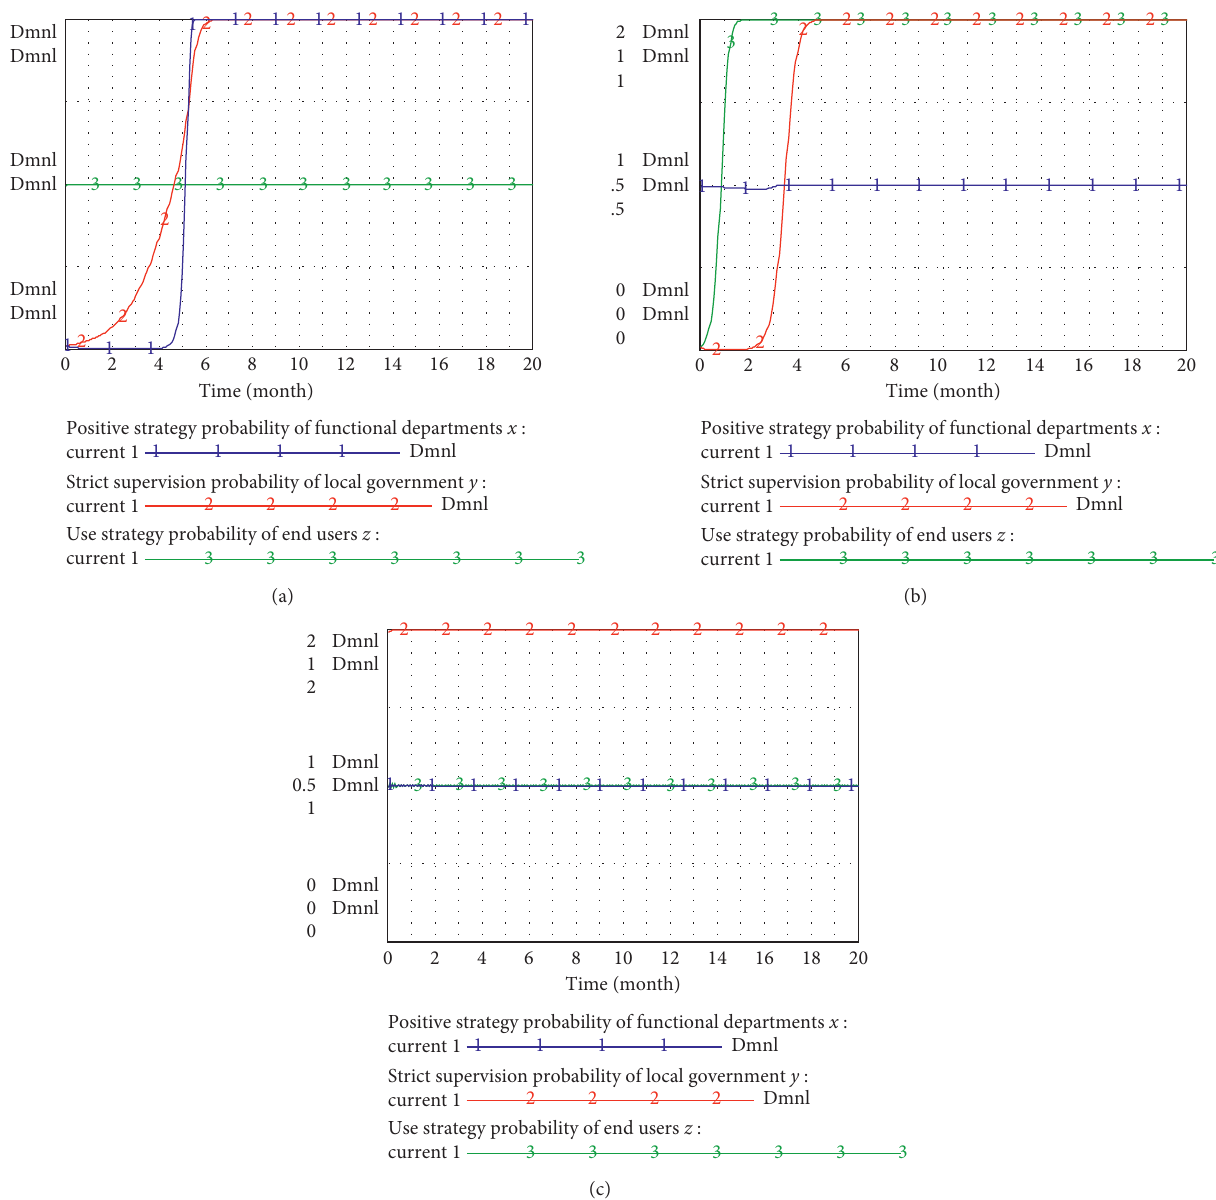
Figure 11: Evolutionary results for different values of x , y , and z : (a) x � 0.01, y � 0.01, and z � 1; (b) x � 1, y � 0.01, and z � 0.01; (c) x � 1, y � 1, and z �